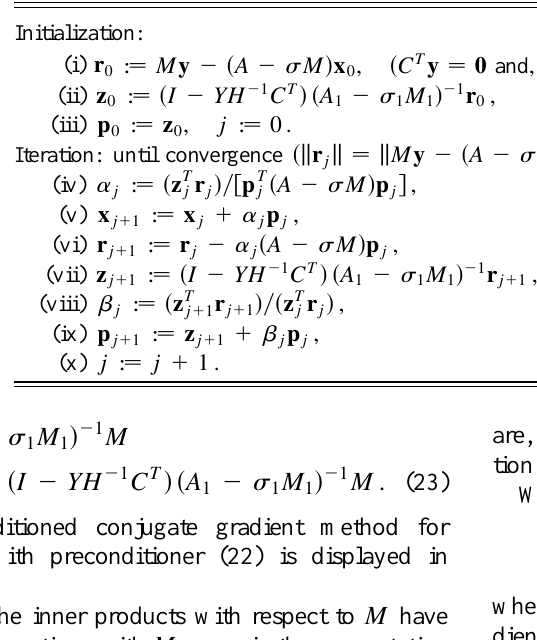
Algorithm 1. Preconditioned conjugate gradient method for (cid:2) A 2 s M (cid:3) x (cid:1) M y